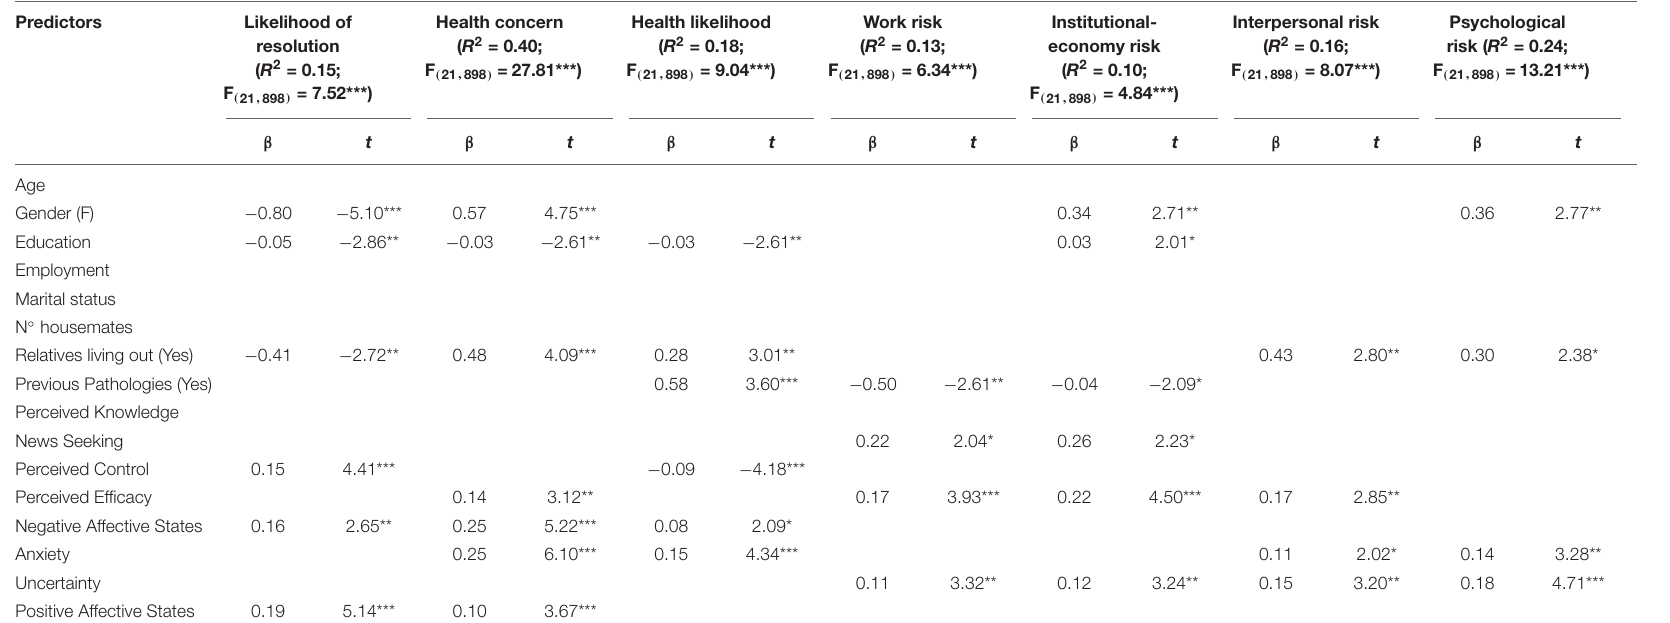
TABLE 5 | Multiple regression analyses.